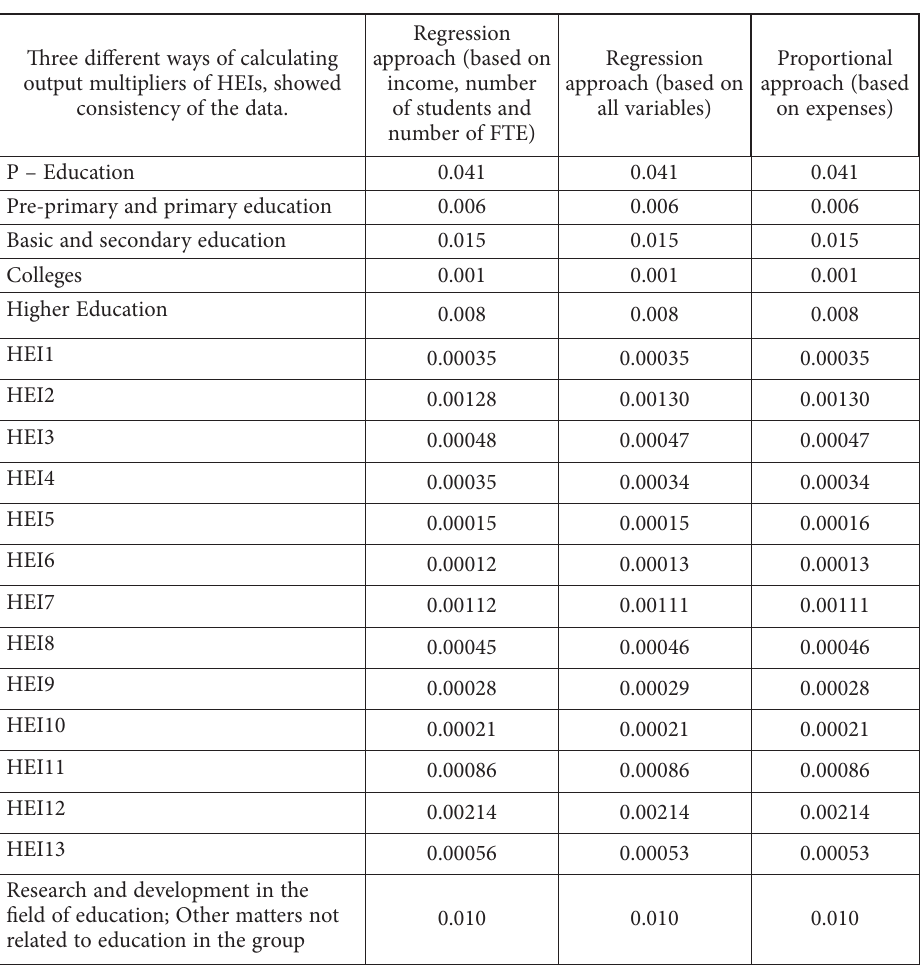
Table 7. Economic effect multipliers of HEIs calculated in three different ways (source : compiled by authors) Three different ways of calculating output multipliers of HEIs, showed consistency of the